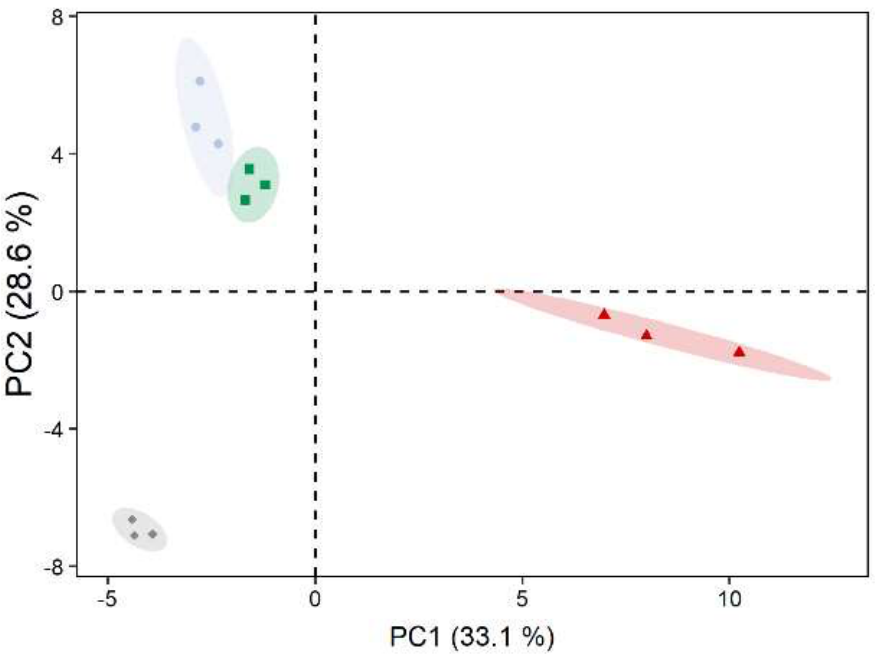
Figure 4. Principal component analysis of metabolite profiles of untreated algae. Diplosphaera epiphytica (red triangles), Edaphochlorella mirabilis (grey diamonds), and two Chlorella vulgaris strains (aquatic C. vulgaris : blue circles, terrestrial C. vulgaris : green squares) were compared; n = 3 biological replicates. Relative abundances for the 75 identified metabolites were used after mean centring.